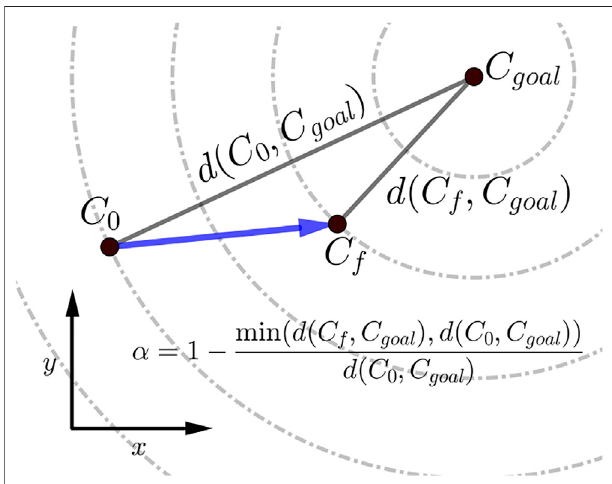
FIGURE 3 | Scalar α , used within the cost expressions, represents the percentage of STS completion and ranges between 0 and 1. The dashed circles show the states that are equidistant from the C goal